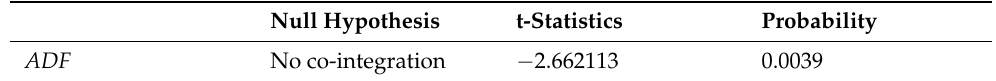
Table 3. Panel cointegration test